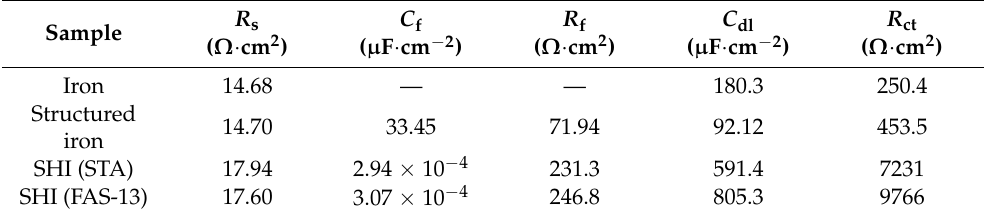
Table 2. Fitting results of electrochemical impedance mapping.